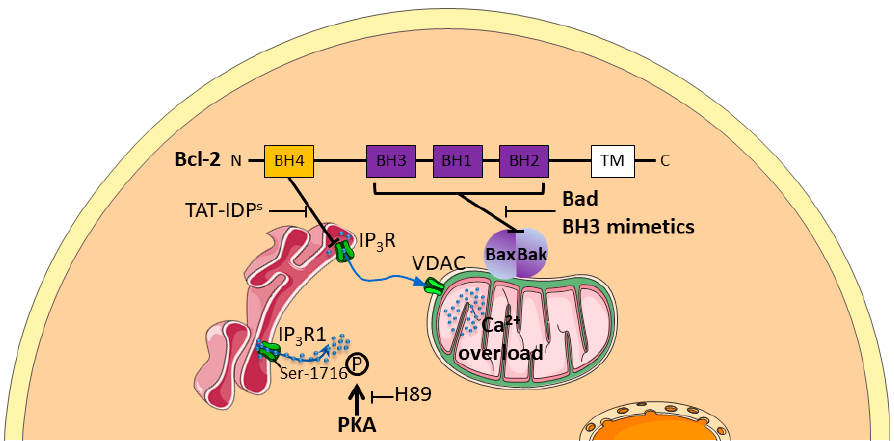
Figure 2. Schematic representation of intracellular Ca 2+ pathways involved in chemoresistance. Anti-apoptotic Bcl-2 protein enhances chemoresistance by a dual role at both the Endoplasmic Reticulum (ER), by inhibiting Ca 2+ depletion through Inositol 1,4,5-trisphosphate Receptors (IP 3 Rs), and the mitochondria by inhibiting apoptotic complex Bax/Bak formation. TAT-fused inositol 1,4,5-trisphosphate receptor-derived peptide (TAT-IDP S ), by inhibiting BH4 domain, enhances Ca 2+ efflux from the ER through IP 3 Rs to mitochondrial Voltage-Dependent Anion Channel (VDAC).